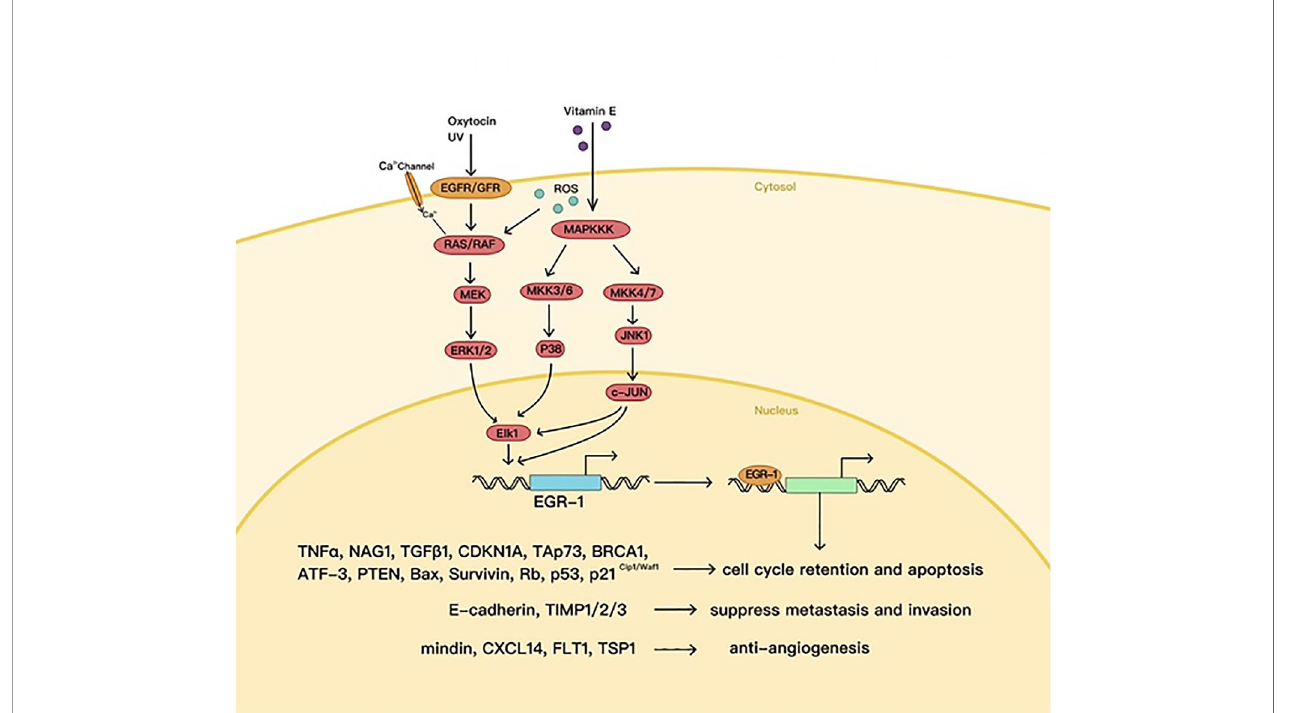
FIGURE 3 | The antitumor effects of